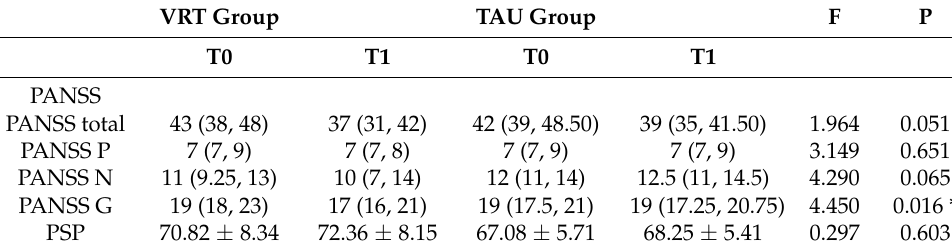
Table 3. Clinical symptoms before and after intervention in the two